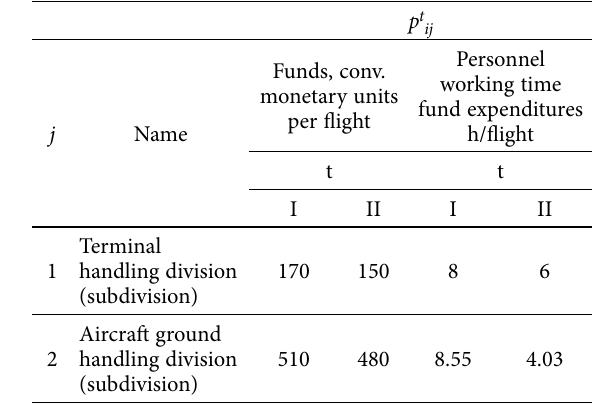
Table 3. Input data as to i resource consumption per j service unit